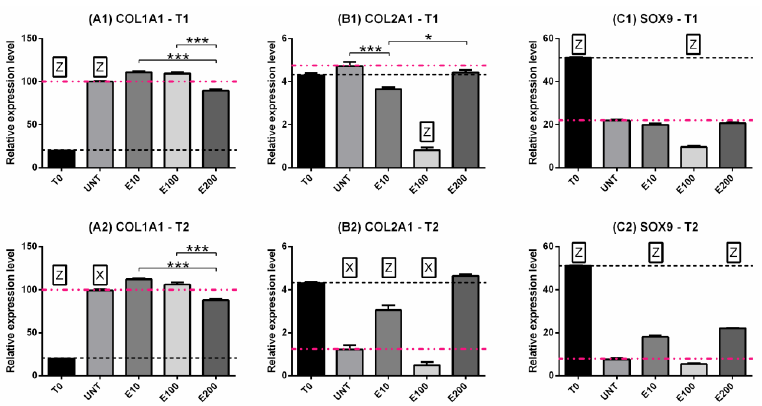
Figure 7. Gene expression: COL1A1 ( A1 , A2 ), COL2A1 ( B1 , B2 ), SOX9 ( C1 , C2 ). Comparison between the time points T1 ( A1 – C1 ) and T2 ( A2 – C2 ) for all treatments. Two-way ANOVA and Tukey’s multiple comparisons test were performed. N = 4; * = p < 0.05; *** = p < 0.001. Z, Y and X were used when the treatment was significantly different (0.001, 0.01 and 0.05, respectively) from all other treatments and to T0 at the considered time point. Data were expressed as mean ± S.E.M. The dashed black line was the expression level corresponding to T0, while the pink one corresponds to the expression level of the UNT group.